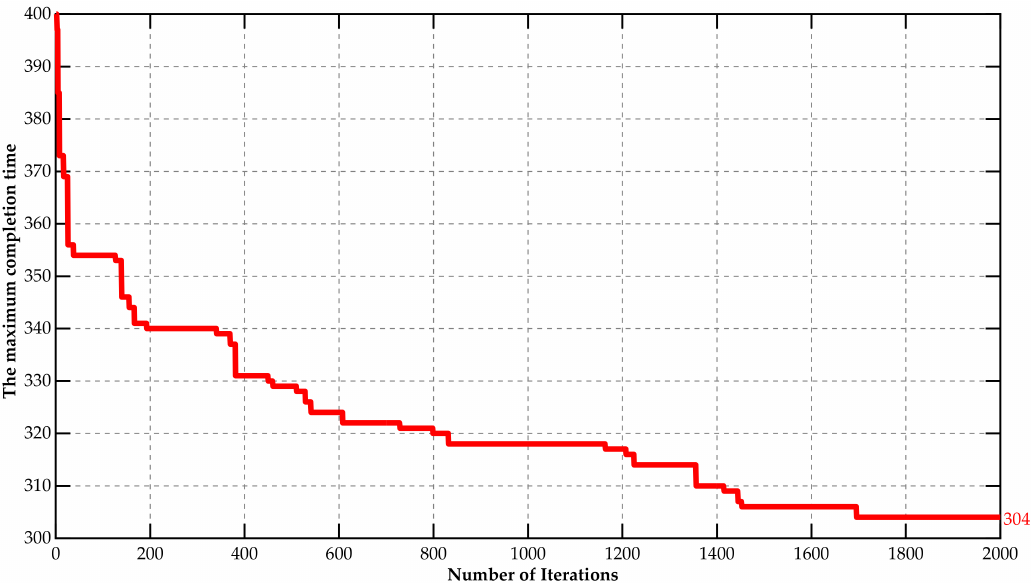
Figure 1. The variation of the maximum completion time optimizing with the constraints of wireless sensors.